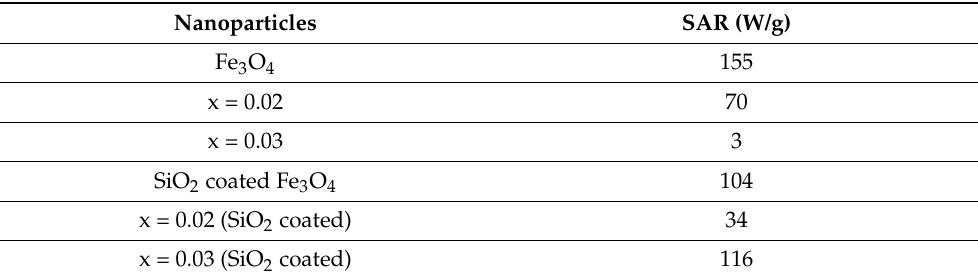
Table 1. SAR values of (Fe 1 − x ,Ti x ) 3 O 4 (x = 0.00, 0.02 and 0.03) nanoparticles.